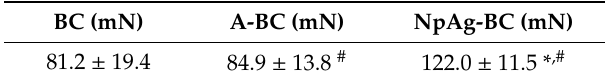
Table 6. Cohesion of bone cement coating (n = 10; * significantly di ff erent from BC— p < 0.05; # significantly di ff erent between group— p < 0.05).